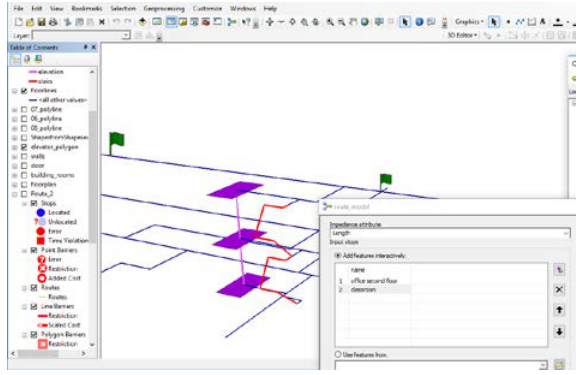
Figure 9. Solve route from a stop in second floor to an exit in